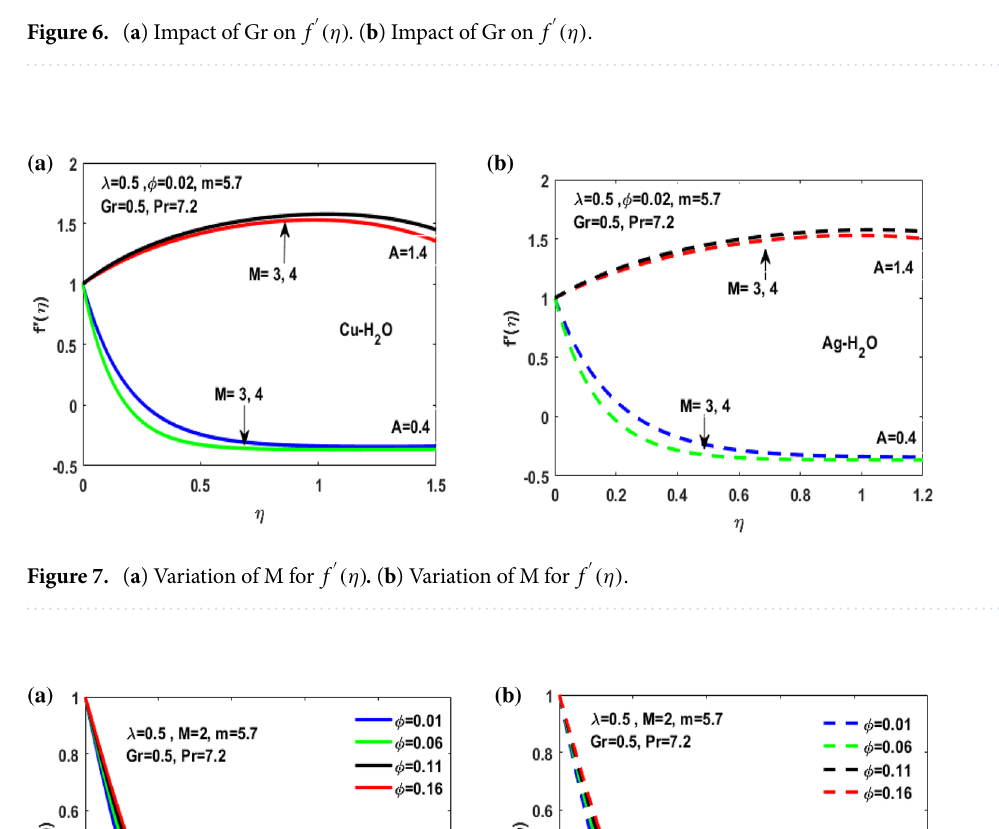
Figure 3a,b it is examined that when A < 1 the velocity profile is concave down for variation in ratio param- eter A for both silver and copper particles with water based nanofluids and velocity profile is concave up for the increasing value of elongating ratio parameter. It is observed that the decreasing value of A represent the condition when stagnation velocity is less than elongating ratio and the increasing value of A represent the state when the stagnation velocity becomes greater than the ratio parameter A. Figure 4a,b shows that the viscosity